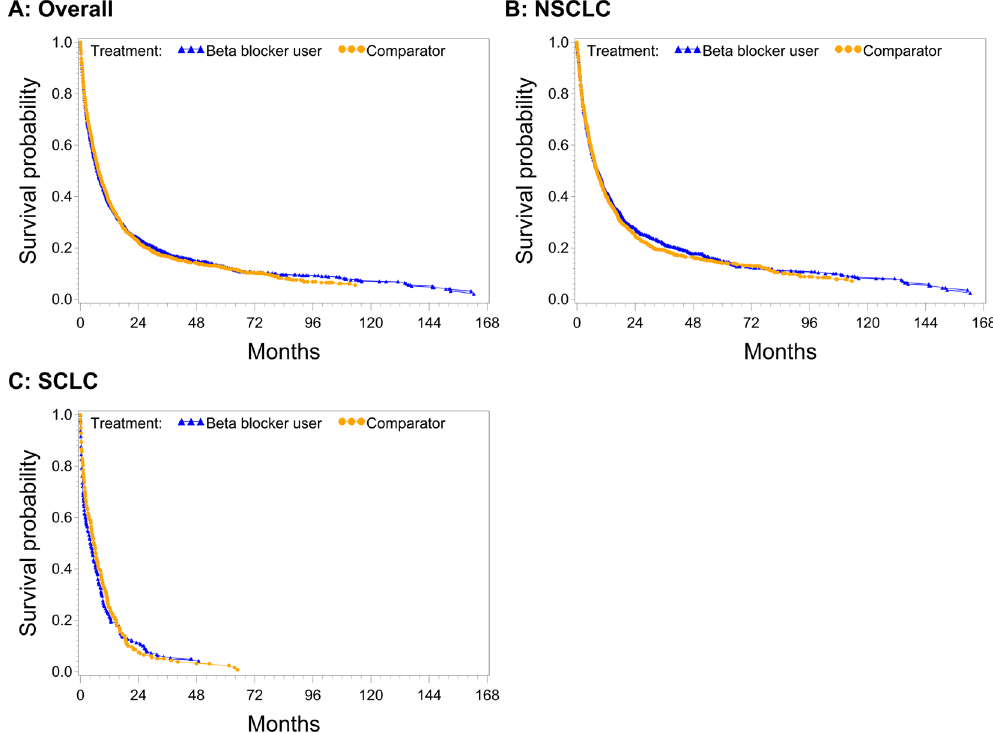
Figure 2. Adjusted survival curves for any β -blocker use in the four month interval prior diagnosis for ( A ) all histologies, ( B ) non-small cell lung cancer (NSCLC) and ( C ) small cell lung cancer